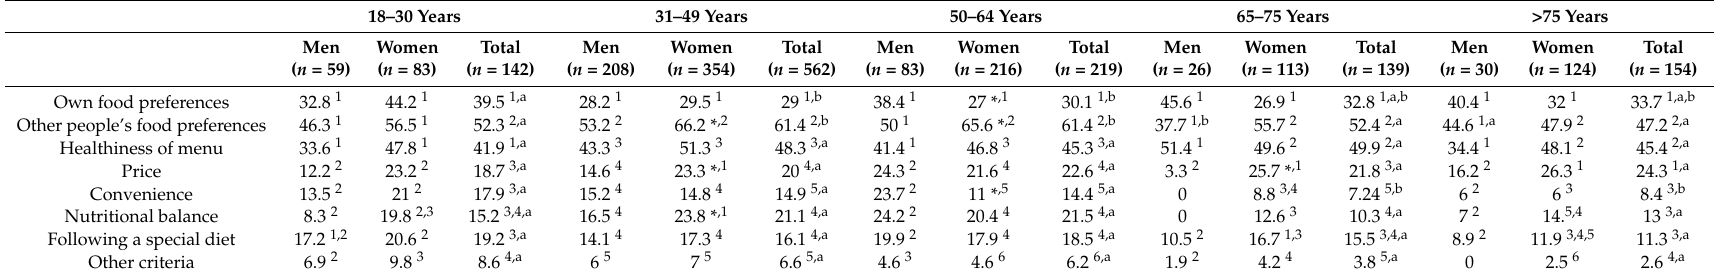
Table 3. Main criteria used when planning meals at home (%) by age and sex (multiple choice